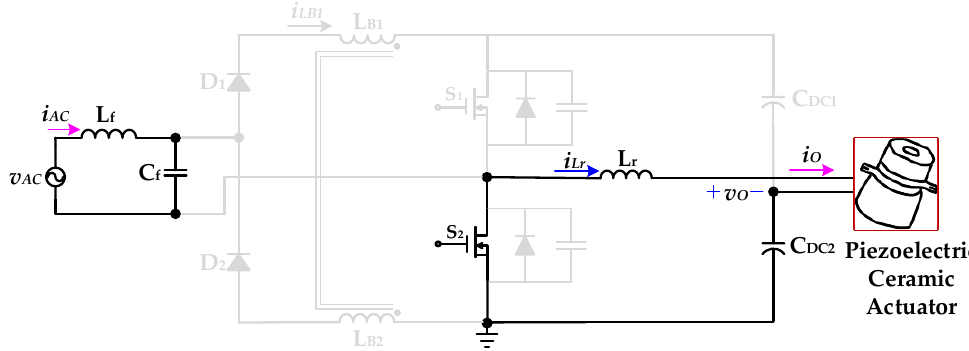
Figure 9. Operation Mode 4 of the proposed drive circuit for the piezoelectric ceramic actuator.